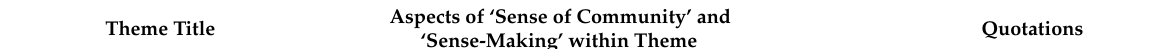
Table 3. Students’ perceptions of physical